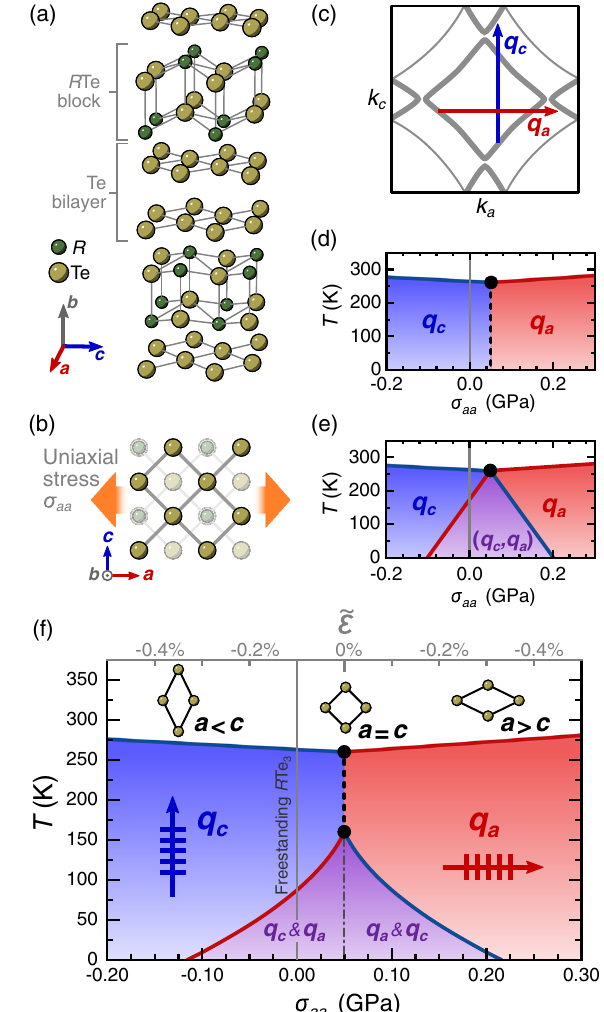
FIG. 1. (a) Crystal structure of R Te 3 . The stacking of the R Te block layers produces a glide plane which breaks C 4 symmetry. (b) Crystal structure viewed along the out-of-plane b axis. Tensile stress along the a axis can invert the native orthorhombic distortion, a ≈ 0 . 999 c . (c) Schematic of the Fermi surface of R Te 3 , neglecting the small b -axis dispersion and bilayer splitting. (d) Temperature- uniaxial stress phase diagram described by Eq. (2) for g > 0 . Solid linesindicatecontinuousphasetransitions,anddashedlinesindicate first-order transitions. The stress axis is defined relative to a freestanding orthorhombic R Te 3 crystal. (e) Phase diagram of Eq. (2) for g < 0 . A region of coexisting CDW order with both wave vectors opens at low temperatures, and all transitions are continuous. (f) Phase diagram of Eq. (6) incorporating higher-order terms, which preserves the first-order transition (between multi- critical points) and the coexistence region. While missing from this model, resistivity measurements (Sec. IV B) suggest the first-order transition persists to lower temperature as well (dash-dotted line). Coefficients appropriate for ErTe 3 are used in calculating (d) –